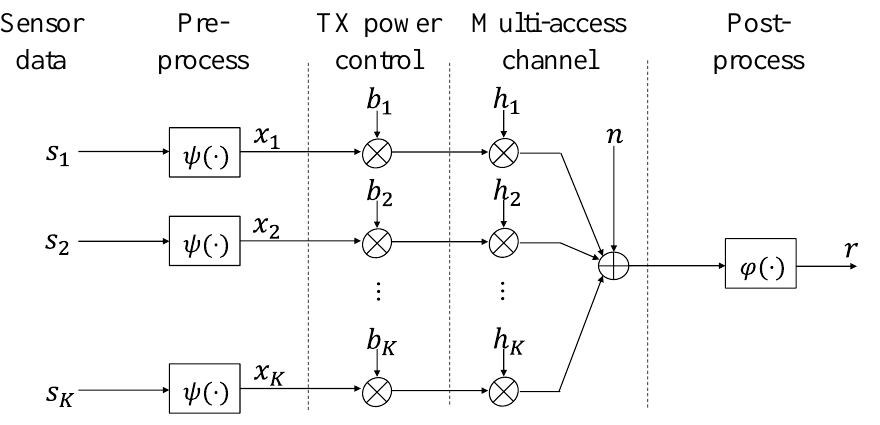
Figure 1. Communication model of AirComp.